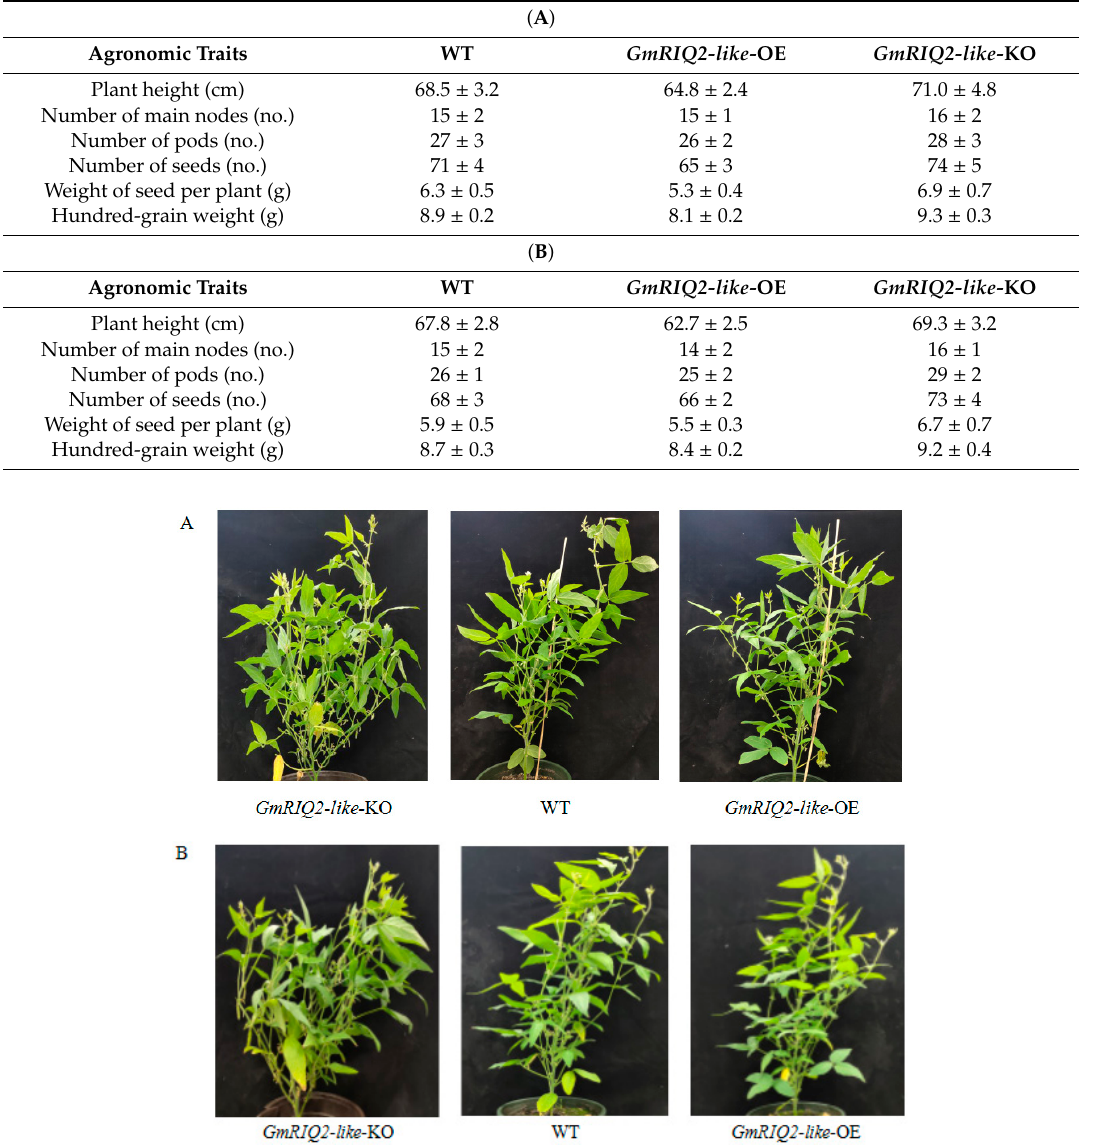
Figure 4. Phenotypes of two-month old GmRIQ2 - like -KO, -OE, and WT transgenic soybean seedlings. ( A ) Phenotype of the T 2 generation of transgenic soybean seedlings. ( B ) Phenotype of the T 3 generation of transgenic soybean seedlings. For each strain, 30 seedlings were